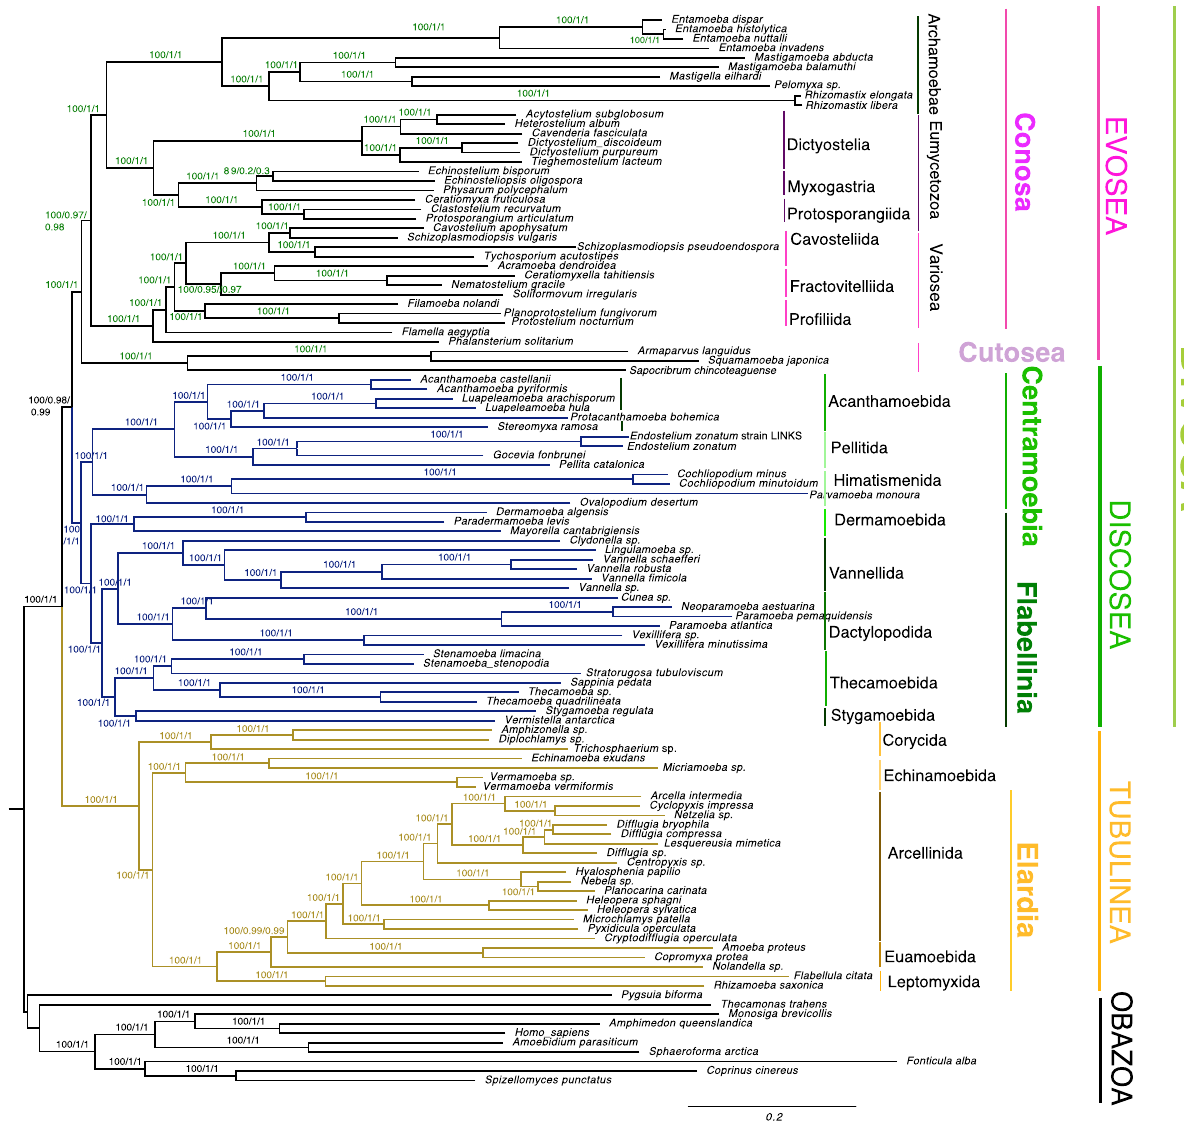
Figure 1. Genome wide phylogeny of the Amoebozoa inferred using Maximum likelihood (ML) in IQ-TREE with LG + G4 + C60 + F model of evolution. The data matrix used to infer this tree consisted of 113,910 amino acid sites from the full dataset, derived from 824 genes and 113 taxa including 10 outgroup taxa. Clade supports at nodes are ML IQ-TREE 1000 ultrafast bootstrap values, obtained using the same model, Internode certainty inferred using QuartetScores and RAxML, respectively. All branches are drawn to scale except branches leading to Archamoebae, and Sapocribrum chincoteaguense, and Parvamoeba monoura , that were reduced to one-third and half,